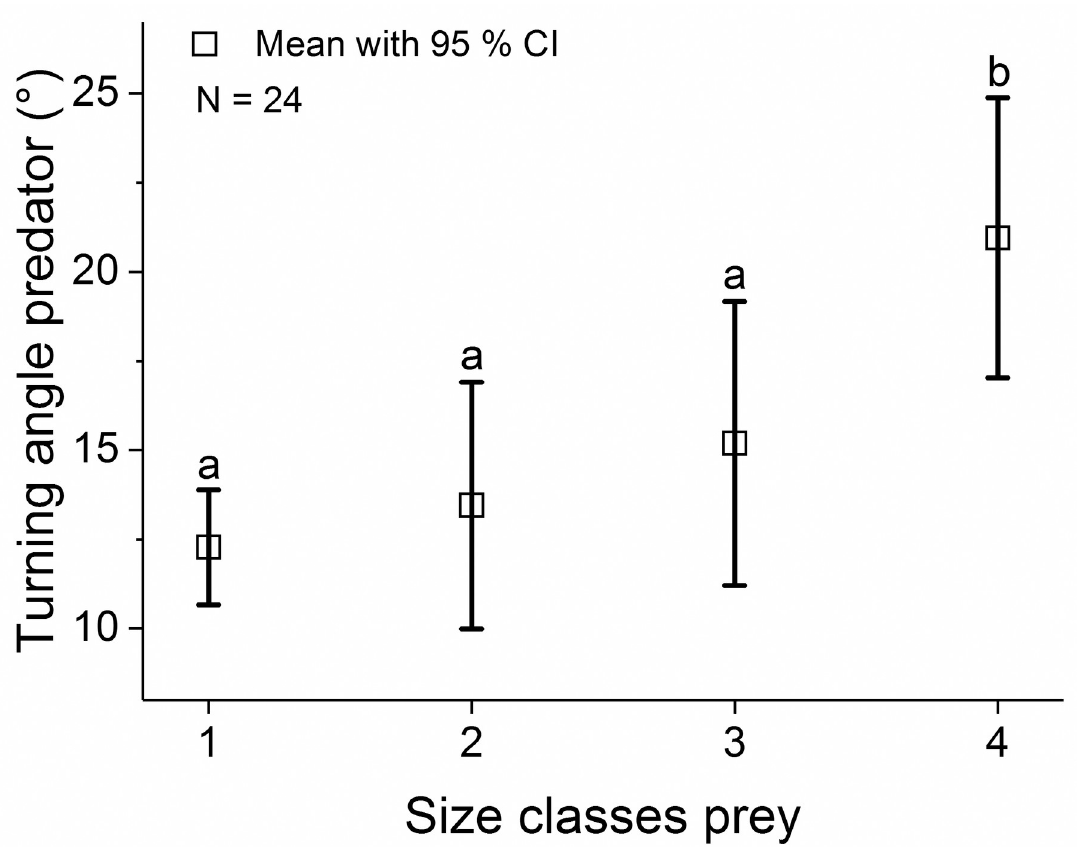
Fig 7. Average turning angle of the predator. Average turning angle of the predator during the failed hunts of whitefish over the four size classes of prey.